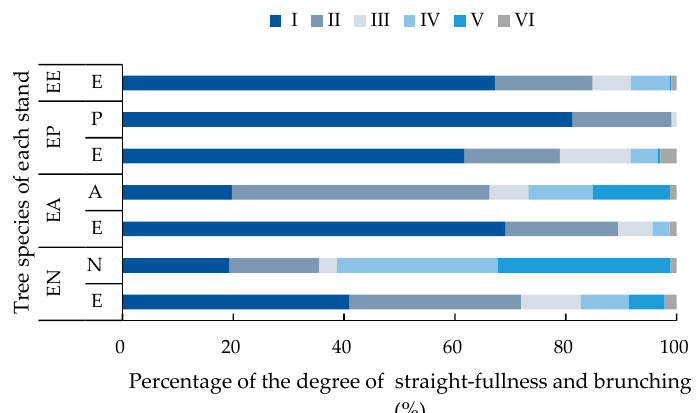
Figure 6. Degree of straight-fullness and brunching of tree stems of different tree species in each stand. Length of different colors shows the percentage of different grades of stem form. EN: mixed plantation of Eucalyptus (E) and N. cadamba (N); EA: mixed plantation of Eucalyptus (E) and A. mangium (A); EP: mixed plantation of Eucalyptus (E) and P. elliottii × P. caribaea (P); EE: pure forest of E. urophylla × E. grandis .